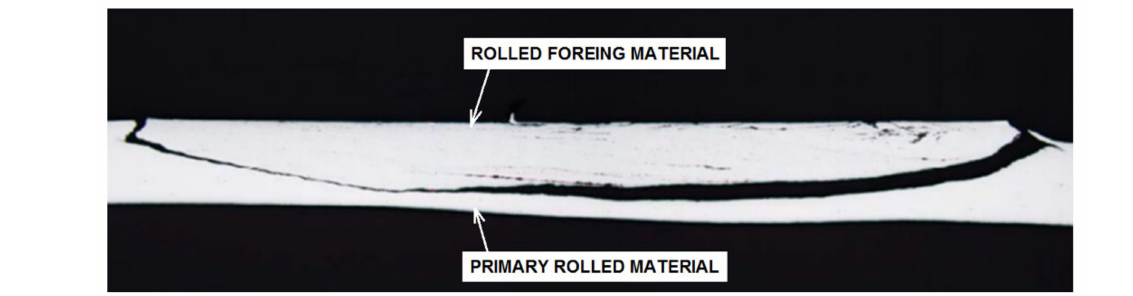
Figure 2. Microstructure of rolled foreign material. Source: own